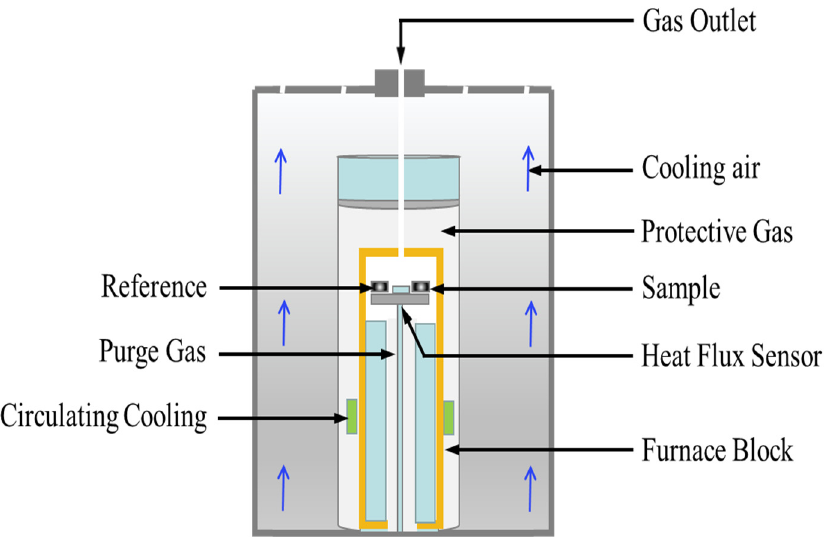
Figure 1. Schematic of the differential scanning calorimeter setup for melting point, fusion enthalpy, and specific heat capacity measurements.